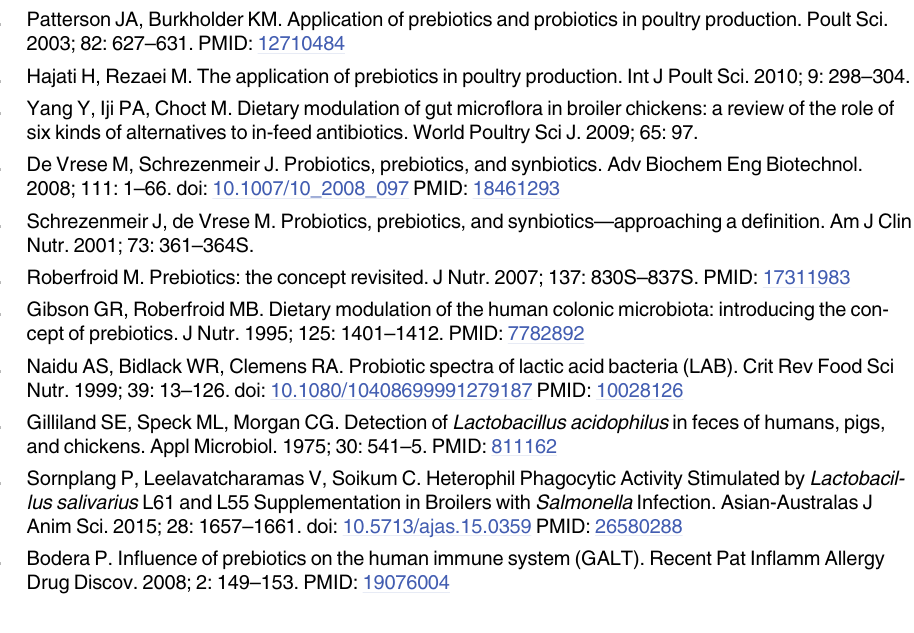
situ fluorescent hybridization (FISH) Fig A. Fluorescent in situ hybridisation (FISH) of single bacterial cells protocol Tab C. Primer sequences used in the RT-qPCR reaction. Tab D. Chicks performance in response to different synbiotics delivered in ovo